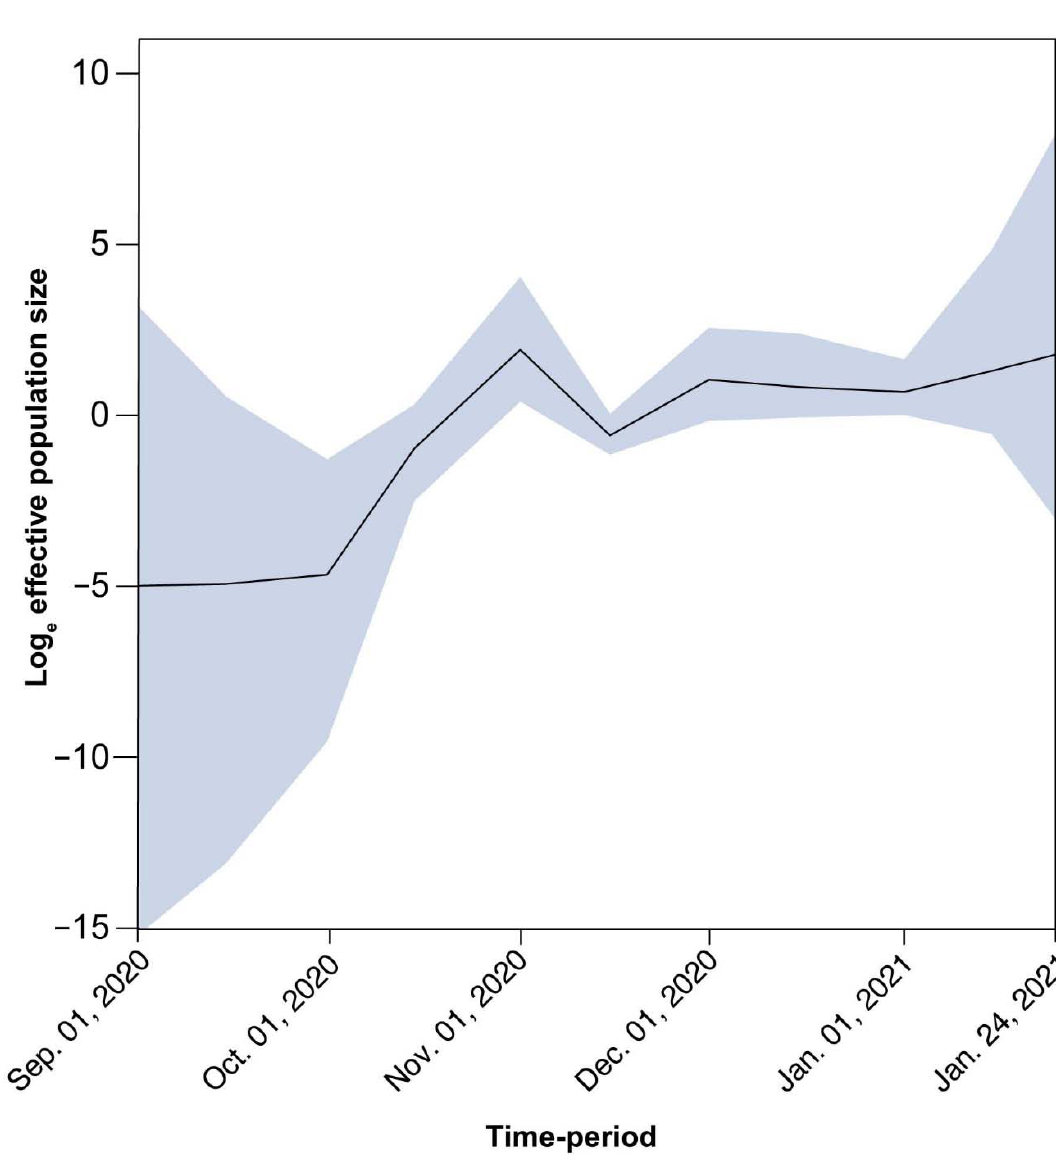
Figure 12. Population size changes in the large Cyprus-specific B.1.258 transmission lineage. The solid black line represents the estimated mean of the effective population size on a log e scale (represented by the y -axis) through the sampling period from September 2020 to January 2021 (represented by the x -axis). The effective population size can be thought of as the number of individuals who contribute offspring to the descending generation. The blue-shaded area marks the associated 95% HPD interval.